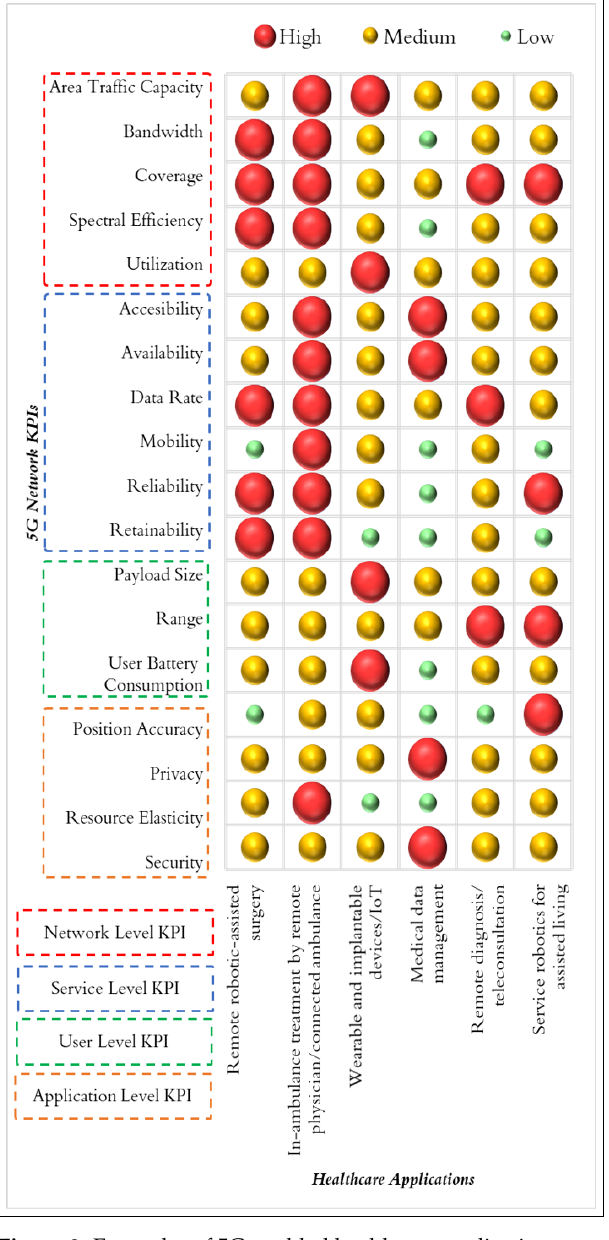
Figure 3. Examples of 5G-enabled healthcare application concepts and their projected needs for some communication